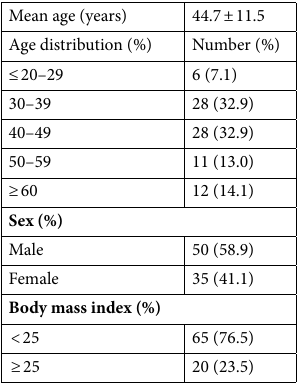
Table 1. Profiles of 85 subjects at initial study.